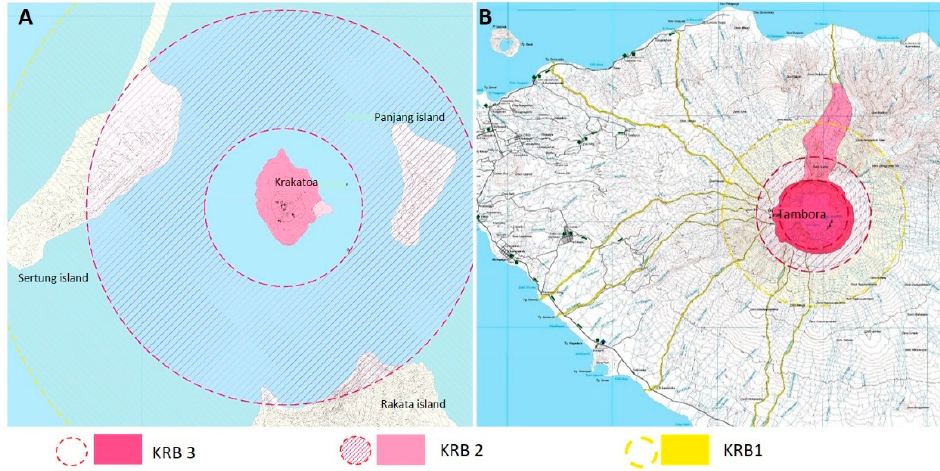
Figure 8 . Example of volcano disaster-prone areas or Kawasan Rawan Bencana (KRB) map in Krakatoa ( A ) and Tambora ( B ) developed by CVGHM (accessible at: https://vsi.esdm.go.id/gallery/index.php?/category/2 (accessed on 27 December 2020)).